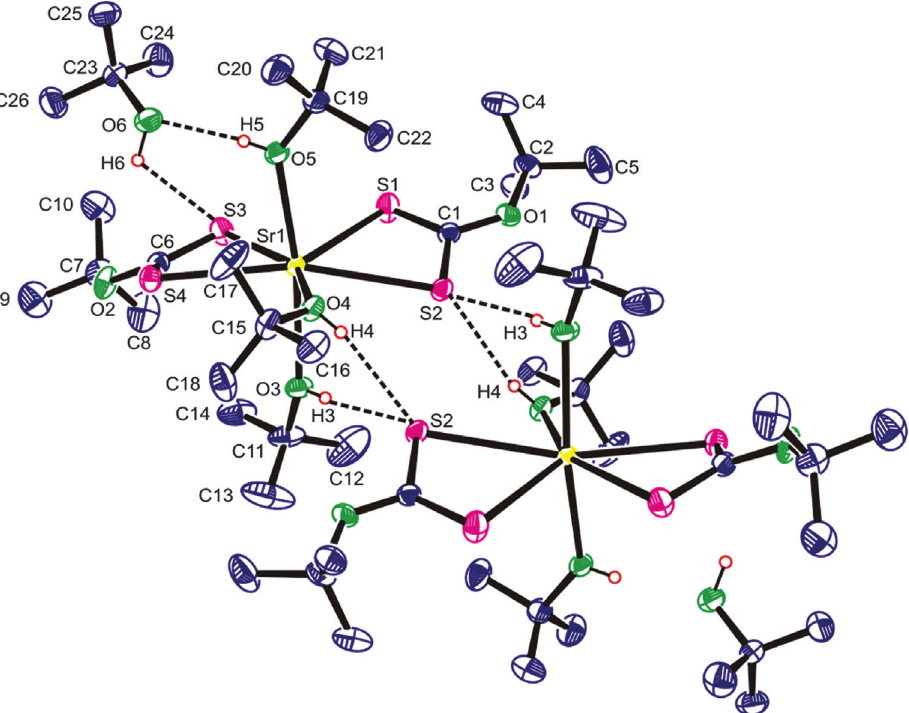
Figure 3 The asymmetric unit of 3 showing the labeling scheme used. Thermal ellipsoids are at the 30% probability level. Only the O-H hydrogens have been included for clarity. Symmetry operation: ′3- x , 1- y , 2- z .